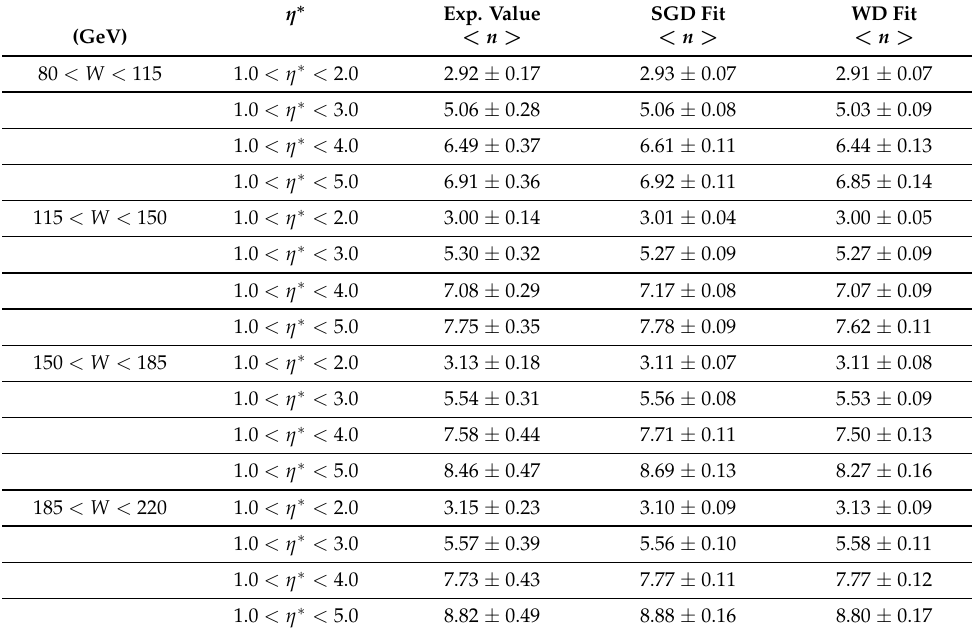
Table 6. Comparison of experimental average multiplicity (cid:104) n (cid:105) with the corresponding values ob- tained from SGD and WD fits to the data [33] at various W and η ∗ intervals. η ∗ Exp. Value